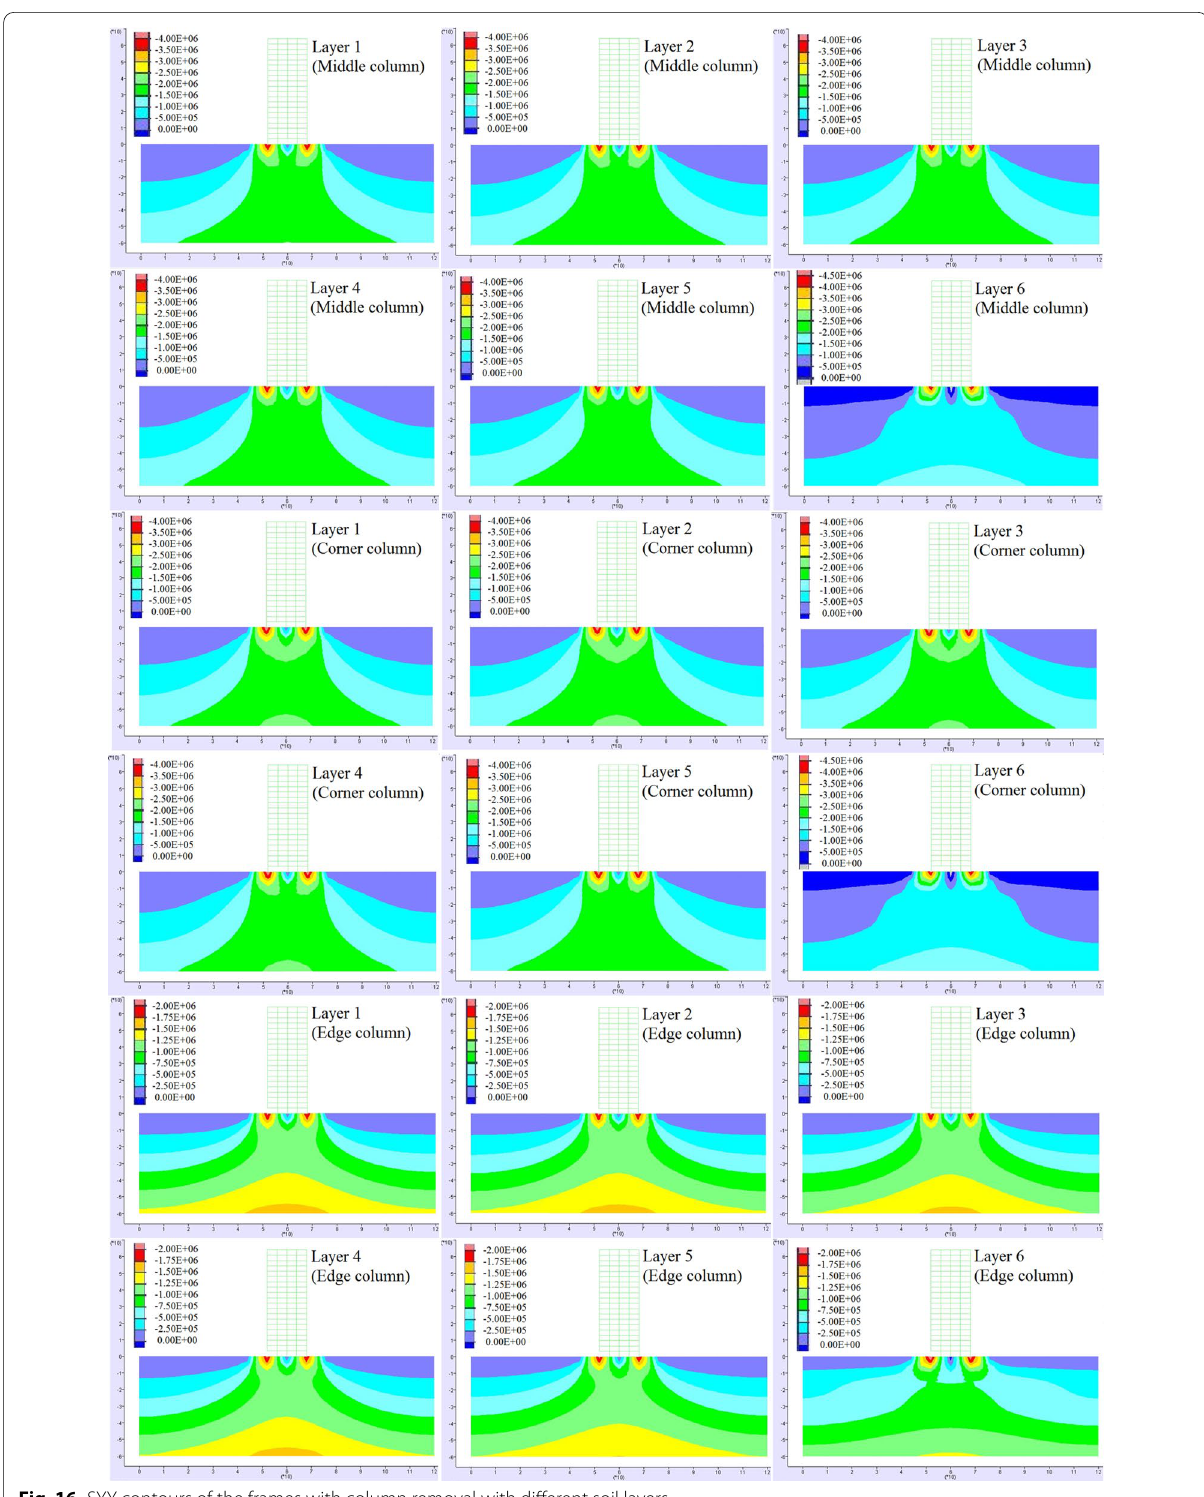
Fig. 16 SYY contours of the frames with column removal with different soil